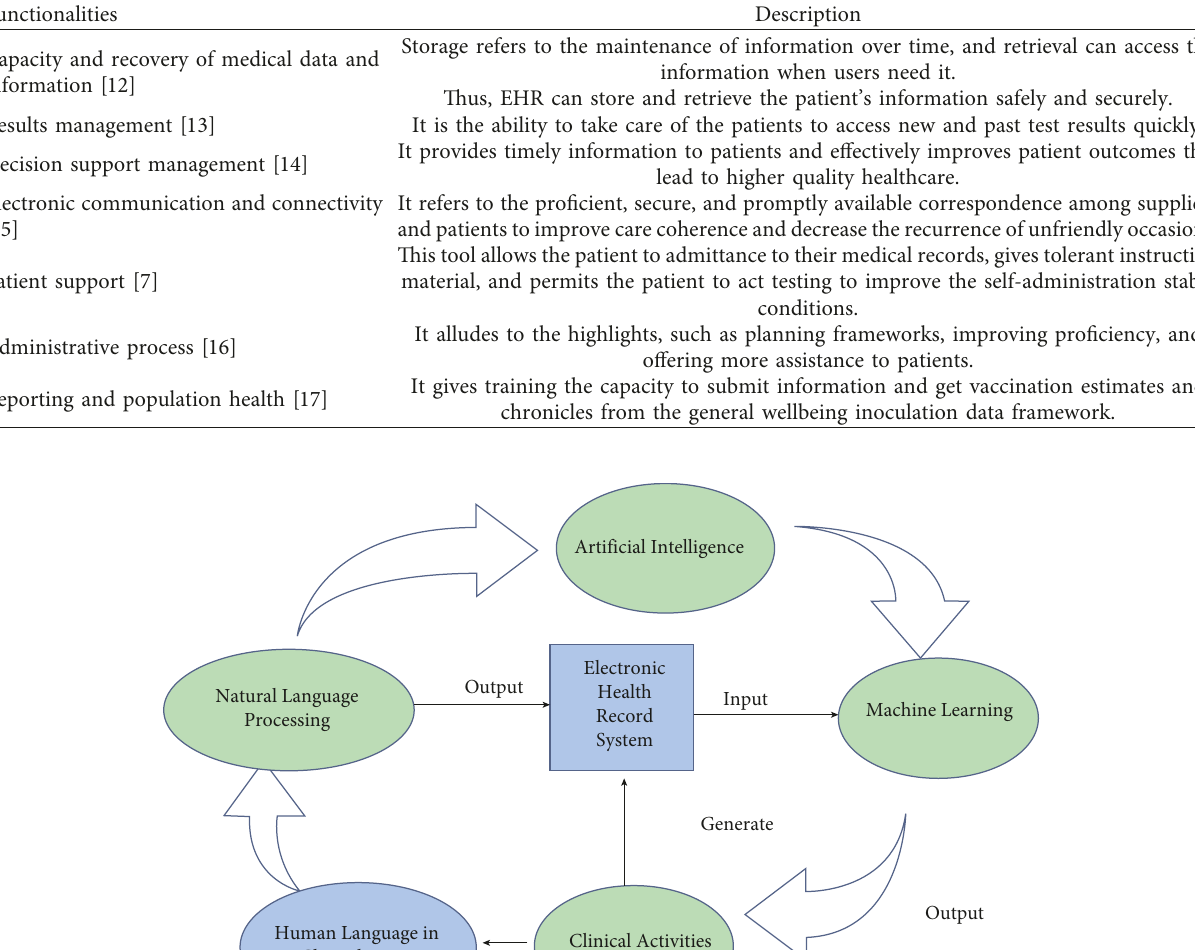
Table 1: Functions of EHR.